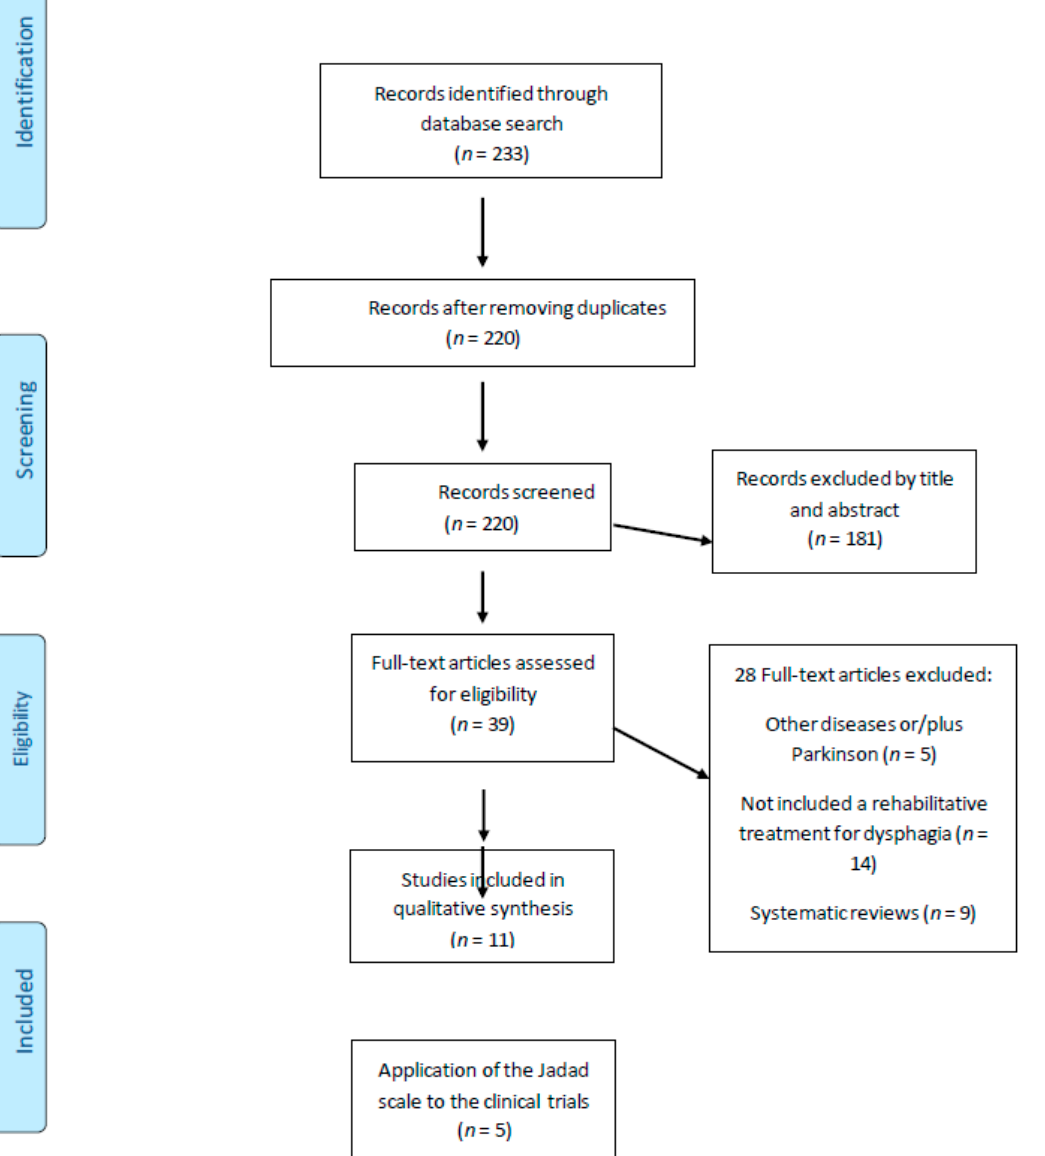
Figure 1. The selected articles from the databases.